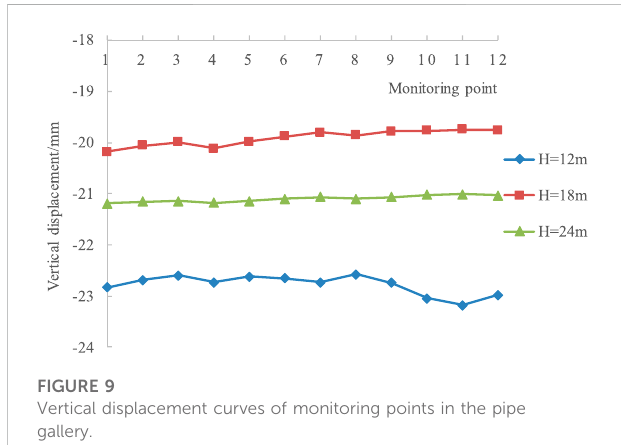
FIGURE 9 Vertical displacement curves of monitoring points in the pipe